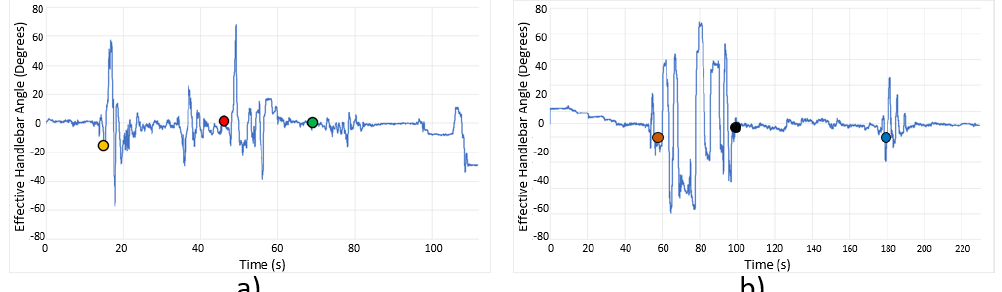
Figure 13. Comparative results of steering angle data from two participants: a) participant P15 and b) participant P10 as a function of time, in balance mode.